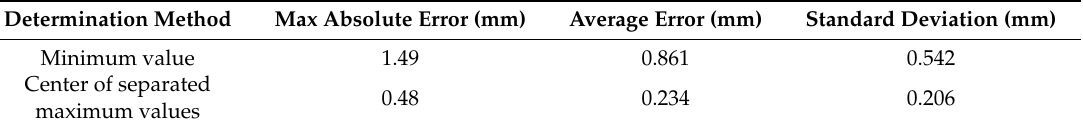
Table 7. Comparison of detection errors from di ff erent determination